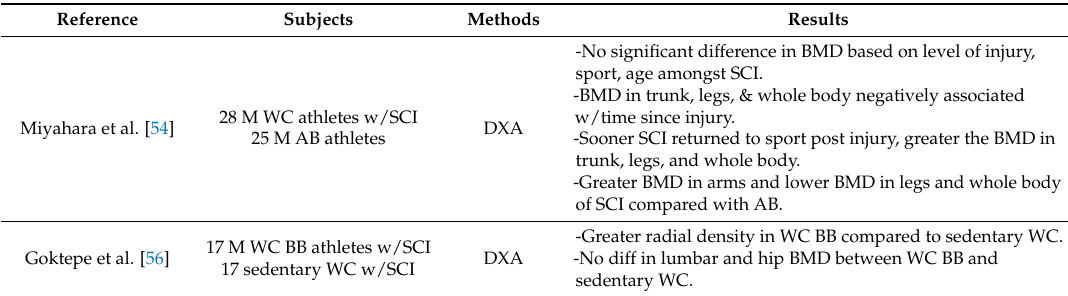
Table 5. Overview of studies examining BMD in para